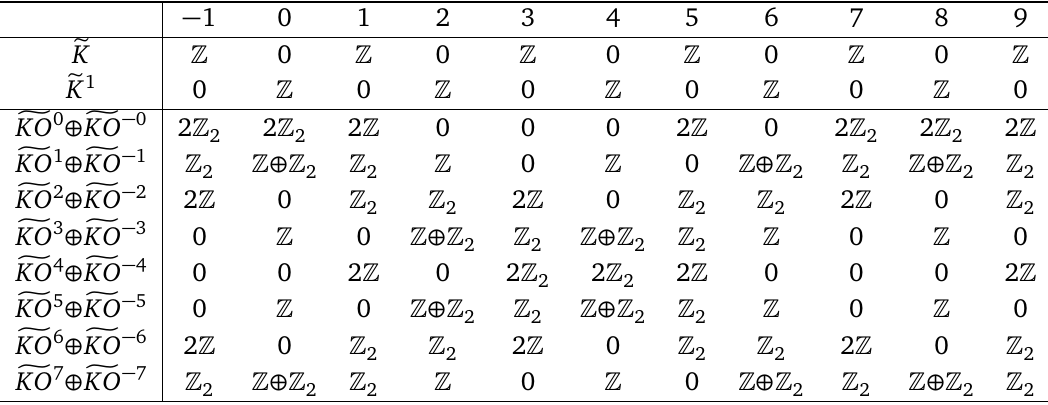
Table 3: The ten K-groups capturing stable branes in the oriented Type II and (un)oriented Type 0 theories discussed